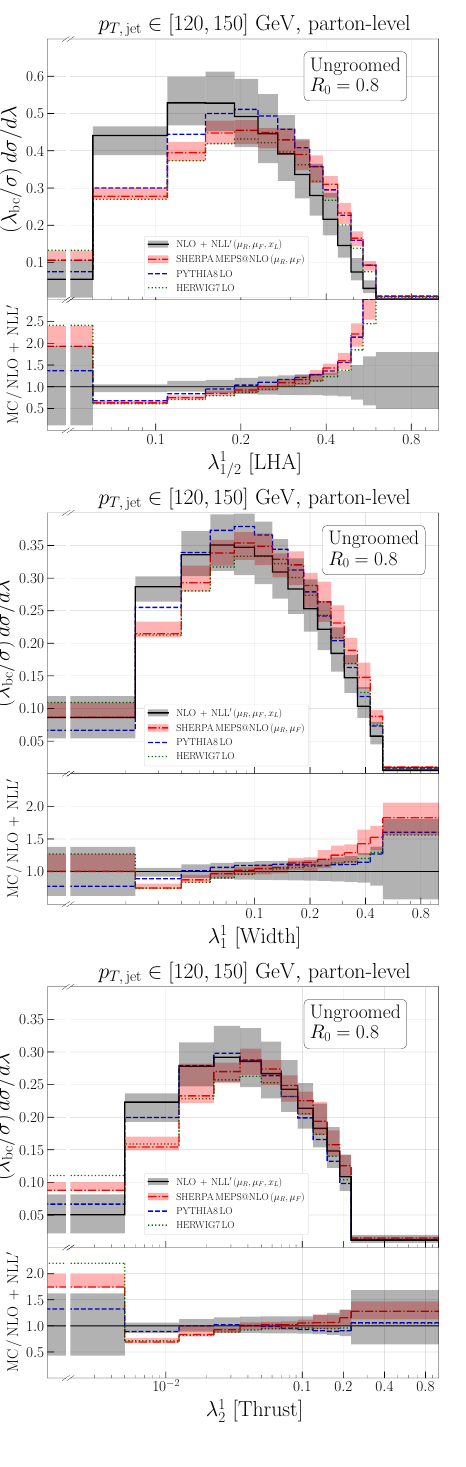
Figure 10 . Comparison of parton-level predictions for ungroomed and groomed jet-angularities in Zj production from P YTHIA , H ERWIG (both LO), and S HERPA (MEPS@NLO) with NLO + NLL 0 results for p T, jet ∈ [120 , 150] GeV. Here λ bc stands for the bin